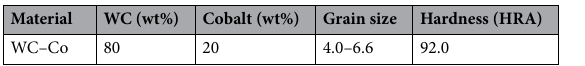
Table 3. Mechanical properties of WC–Co.